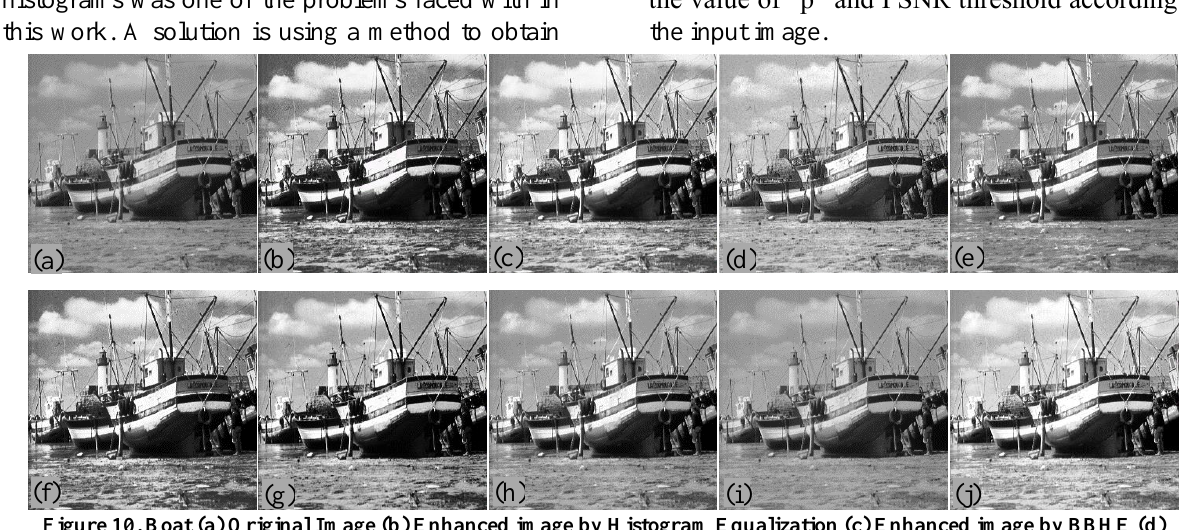
Figure 10. Boat (a) Original Image (b) Enhanced image by Histogram Equalization (c) Enhanced image by BBHE (d) Enhanced image by ABC (e) Enhanced image by RSIHE (f) Enhanced image by DSIHE (g) Enhanced image by [19] (h) Enhanced image by proposed method (i) Enhanced image by SDDMHE (j) Enhanced image by [21].